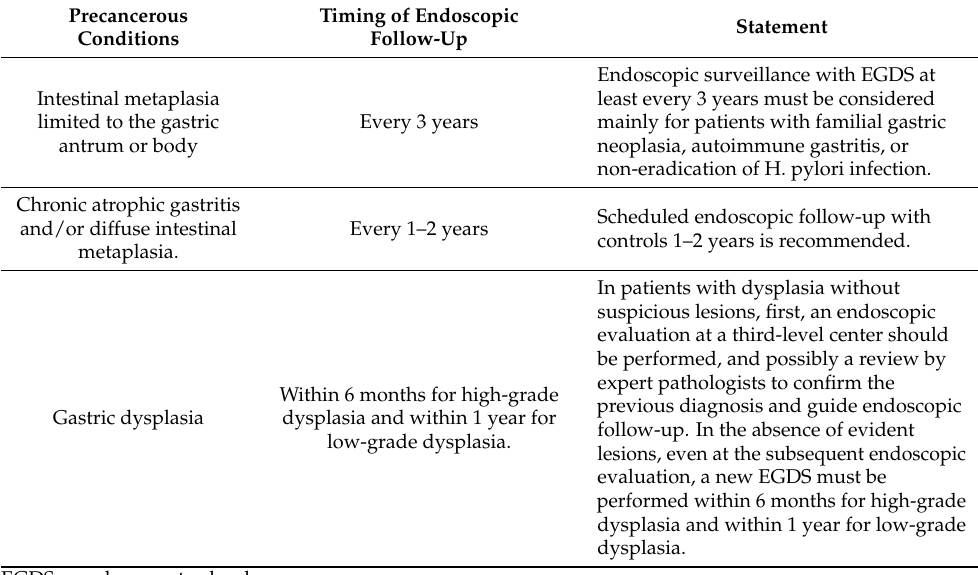
Table 1. Follow-up of precancerous